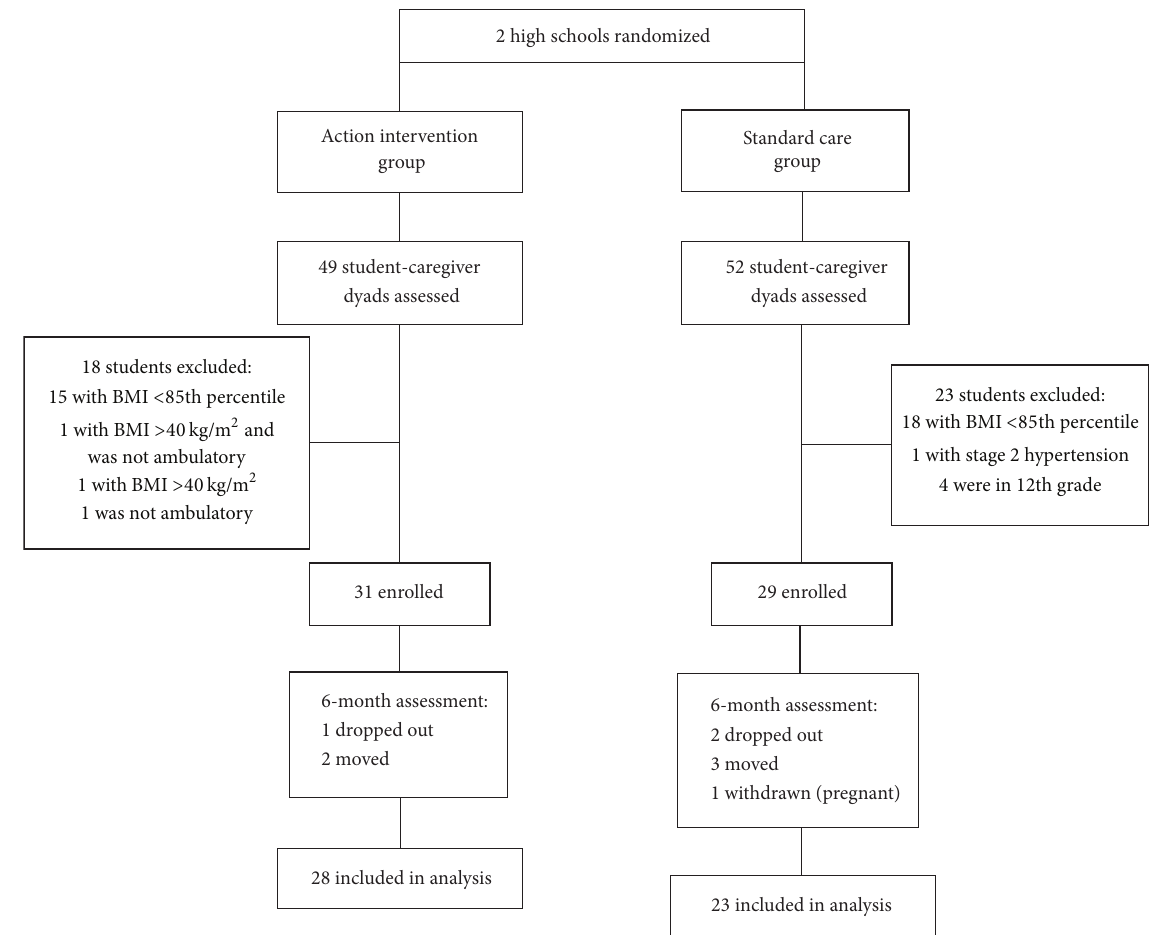
Figure 1: Diagram of randomization, enrollment, and